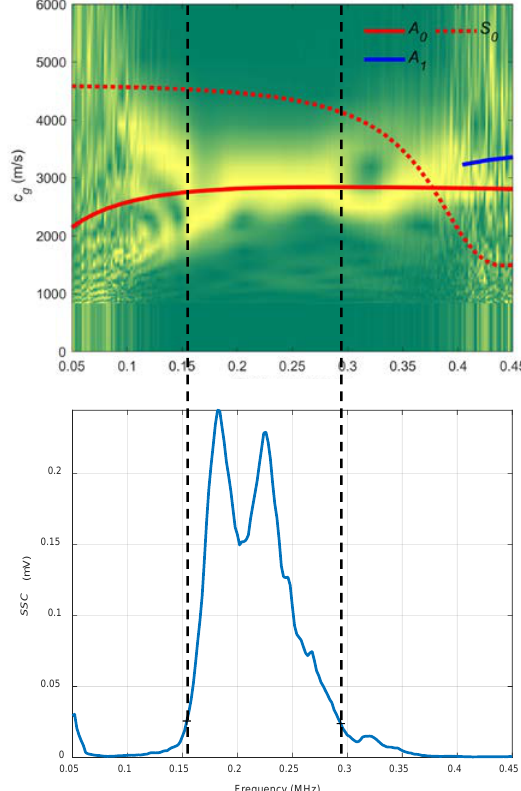
Figure 21. Combined spectrogram and system sensitivity curves ( SSC ) from the air coupling setup to measure the mortar plate: 10°.